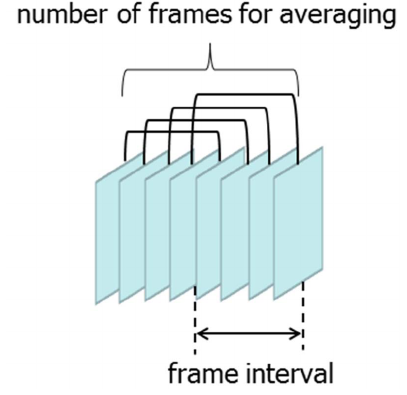
Figure 2. Illustration of frame averaging procedure in velocity estimation.